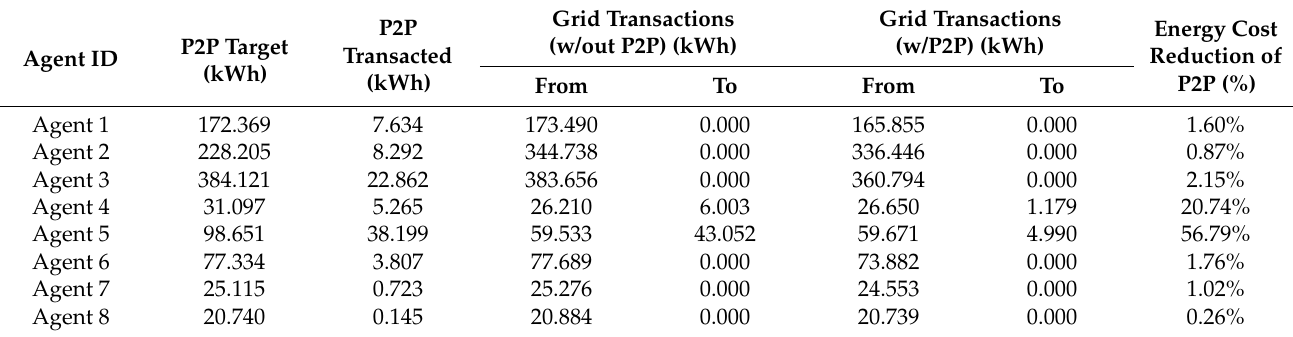
Table 2. Energy community results considering the TabNet